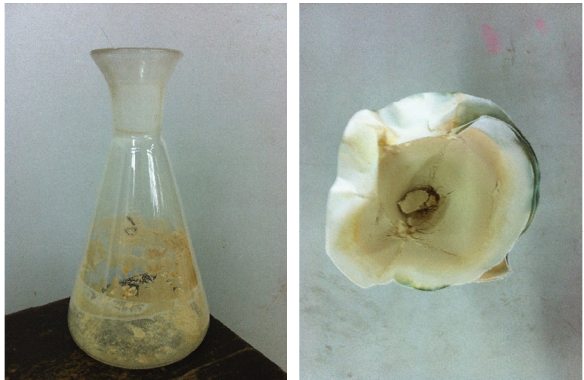
Figure 5: The residues in the conical flask and on the filter paper after drying.